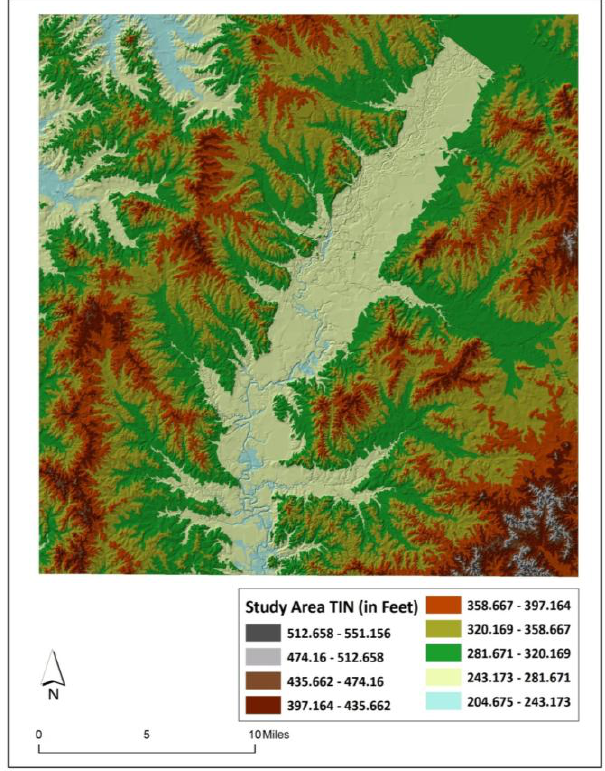
Figure 4. Triangular Irregular Networks (TIN) of the study region.